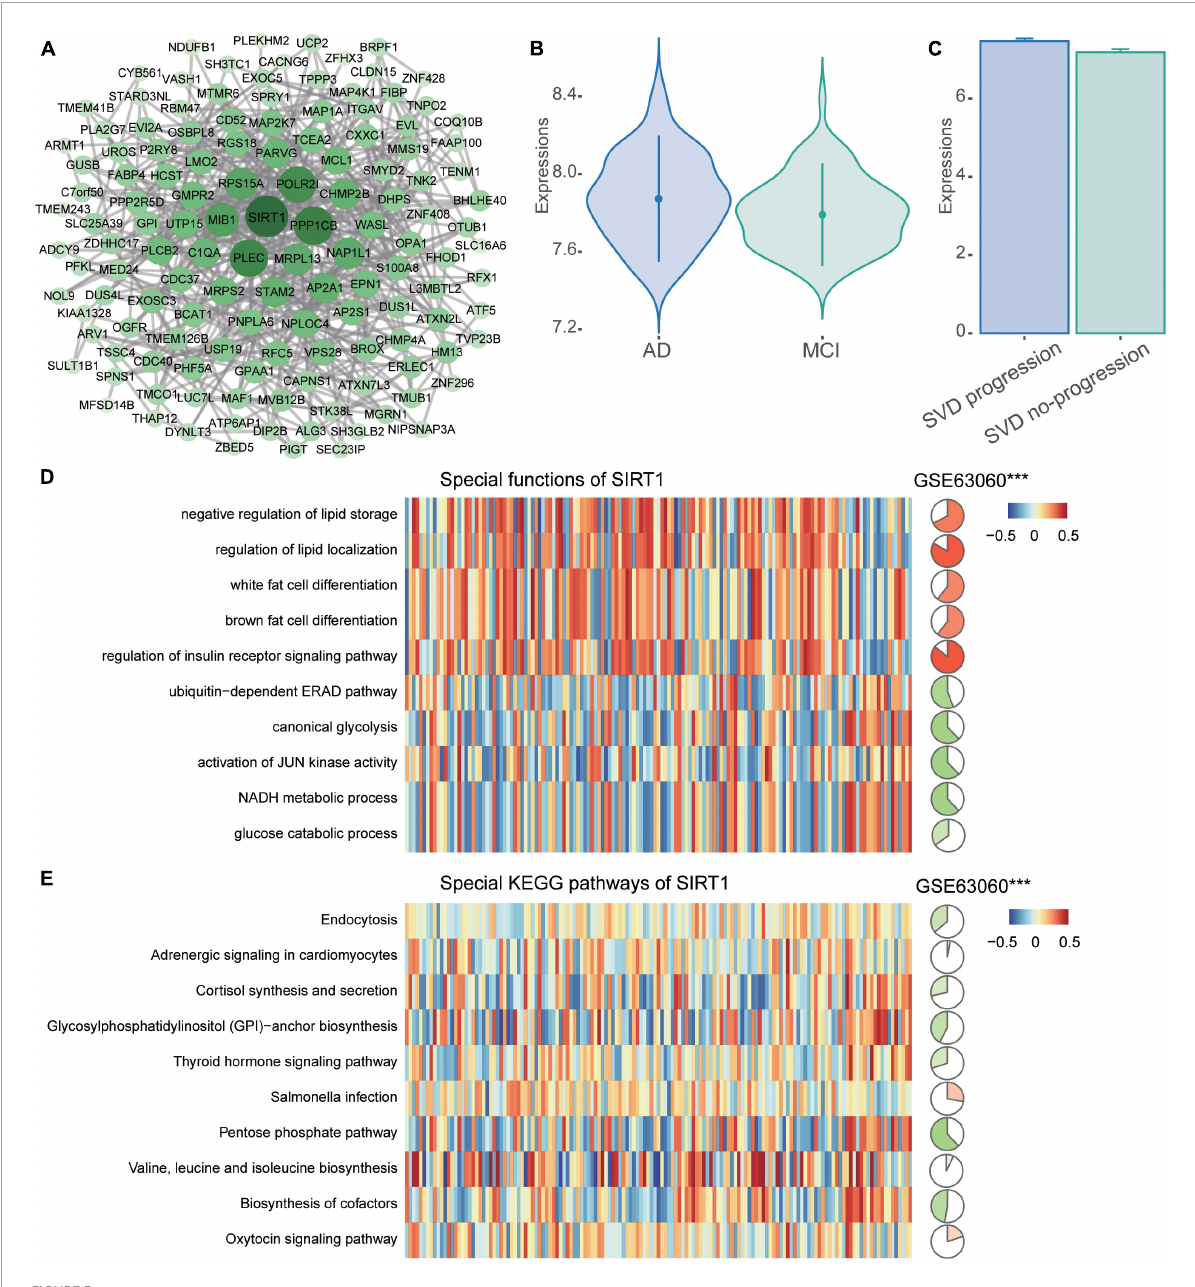
FIGURE5 PPI network of common DEGs. (A) The PPI network of common DEGs was constructed using the STRING website. (B) Expression of SIRT1 in AD and MCI in the GSE63060 dataset. AD, Alzheimer’s disease; MCI, mild cognitive impairment. (C) Expression of SIRT1 in CSVD progression and CSVD no-progression in the GSE162790 dataset. CSVD, cerebral small vessel disease. (D) Correlation of SIRT1 with biological processes. (E) Correlation of SIRT1 with KEGG pathways. Red is activation, and blue is inhibition in AD in the heatmap. Red is positive correlation and green is negative correlation in circle graphs. ∗∗∗ P <